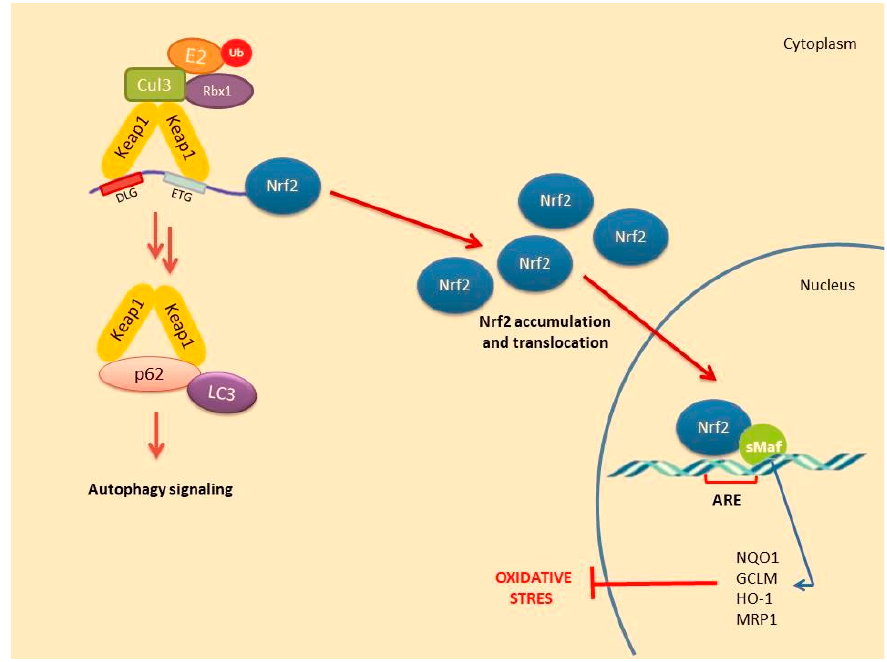
Figure 3. Nrf2 activation mechanism-canonical pathway associated with the induction of autoph-